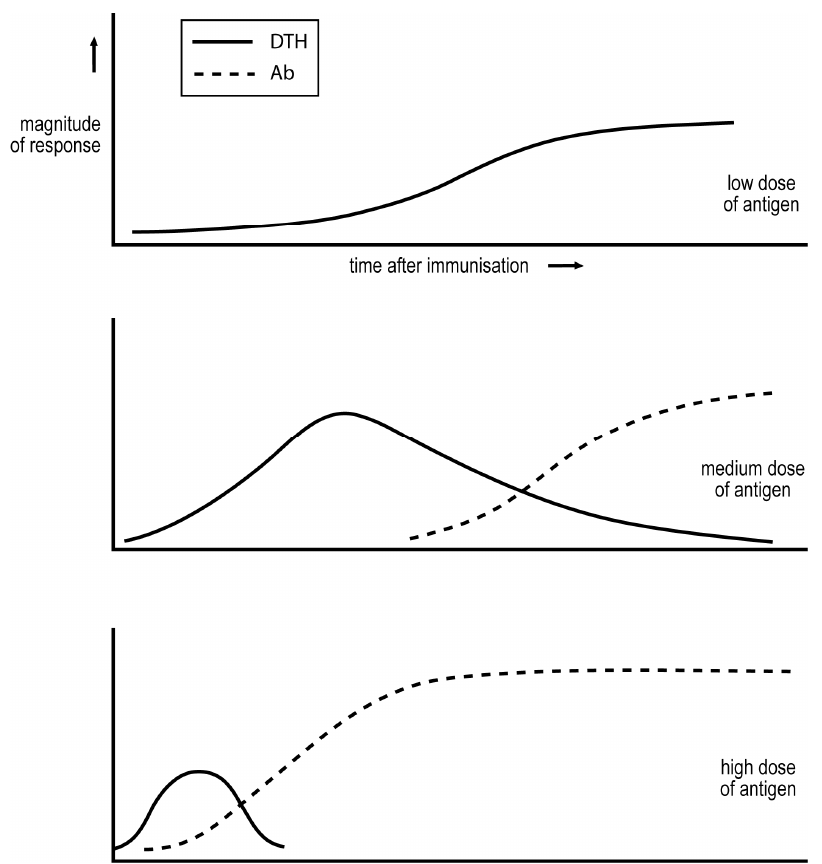
Figure 1. Dependence of cell-mediated/IgG antibody nature of response on dose of antigen and time after antigen impact.